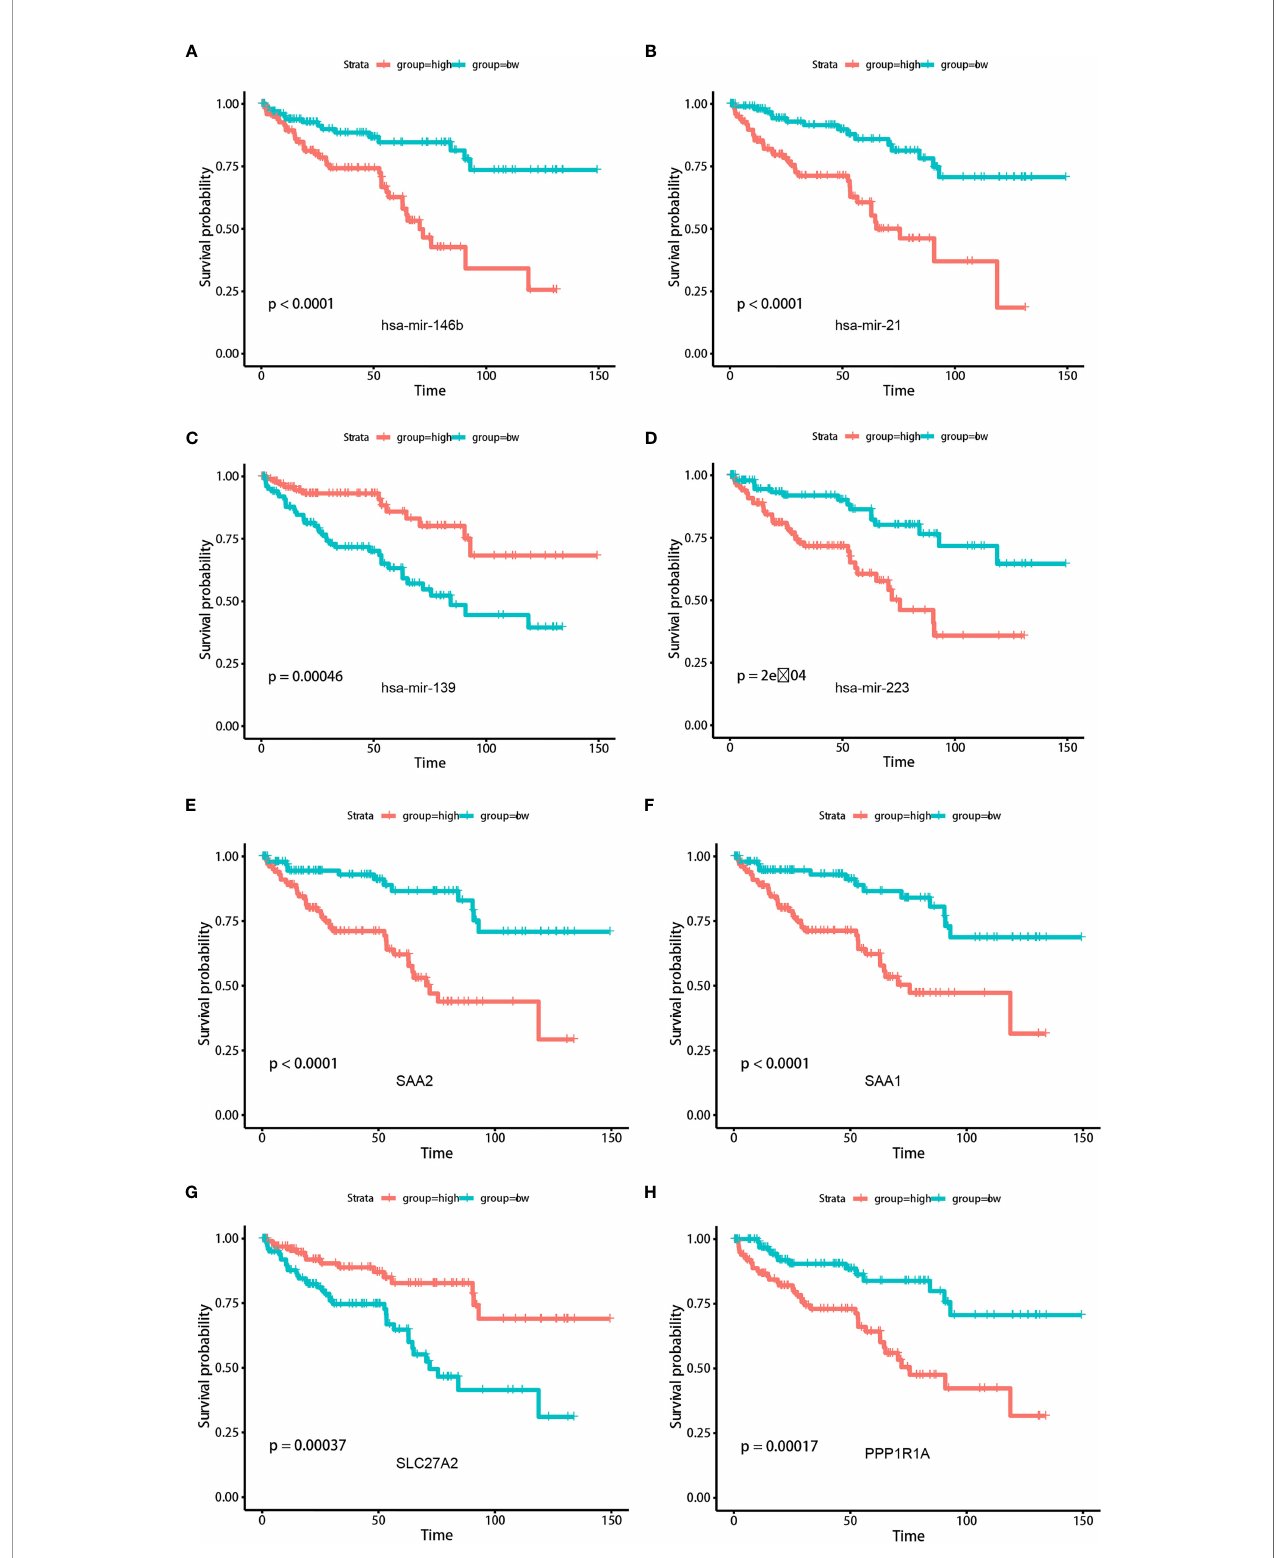
FIGURE 7 | Kaplan-Meier analysis was conducted to assess the signi fi cantly risk signature expressed differentially (top miRNAs and mRNAs) in two TMEscore groups. (A) hsa-mir-146b. (B) hsa-mir-21. (C) hsa-mir-139. (D) hsa-mir-223. (E) SAA2. (F) SAA1. (G) SLC27A2. (H)